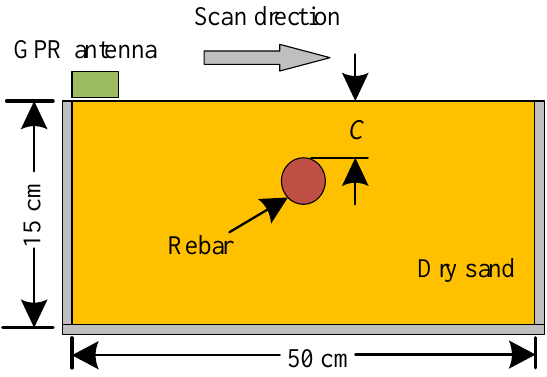
Figure 10. The setup of the field experiment.